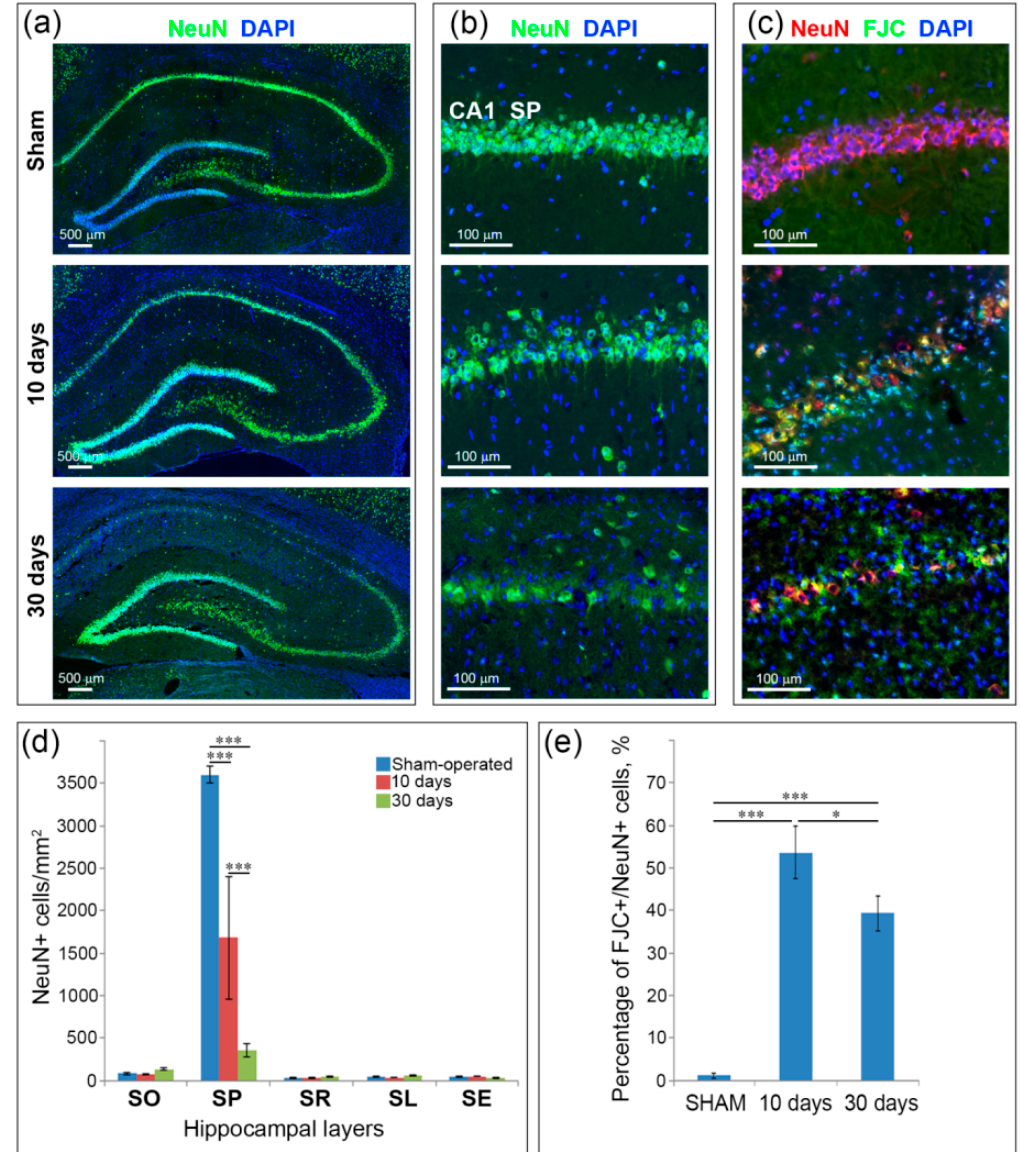
Figure 1. Neuronal loss in the hippocampus 10 and 30 days after global cerebral ischemia (GCI). ( a ) Example microphotographs of neuronal (NeuN)-positive neurons in the hippocampus of sham-operated controls and animals 10 and 30 days after GCI; ( b , c ) magnified views of NeuN-positive ( b ) and double-labeled Fluoro-Jade C (FJC)\NeuN-positive ( c ) neurons in the CA1 field of the hippocampus of sham-operated controls and animals 10 and 30 days after GCI; ( d ) comparison of NeuN+ cells in the CA1 field between sham-operated controls and animals 10 and 30 days after GCI; ( e ) percentage of FJC+\NeuN+ cells from NeuN-positive neurons in the CA1 field in sham-operated controls and animals 10 and 30 days after GCI. Significant differences relative to the sham-operated group, according to ANOVA after LSD correction for multiple comparisons: *— p < 0.05, ***— p < 0.001.